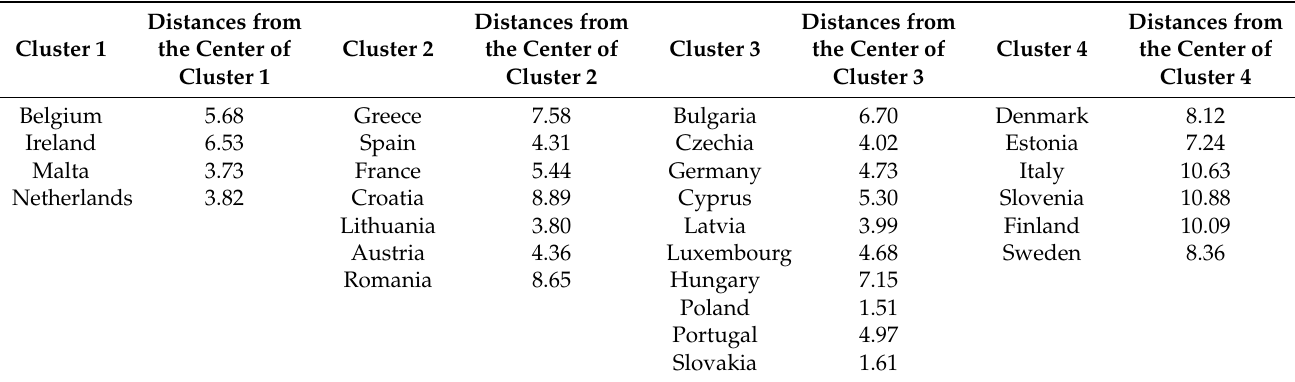
Table 8. Elements of clusters with distances form centers.